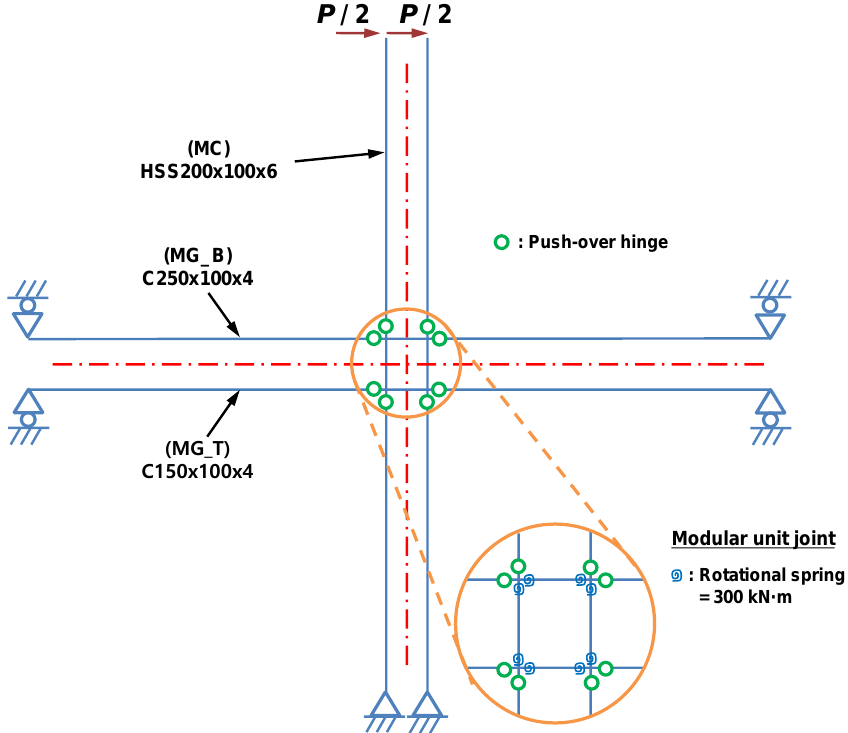
Figure 20. Push-over analysis model of IC_OB_F specimen. (unit: mm).